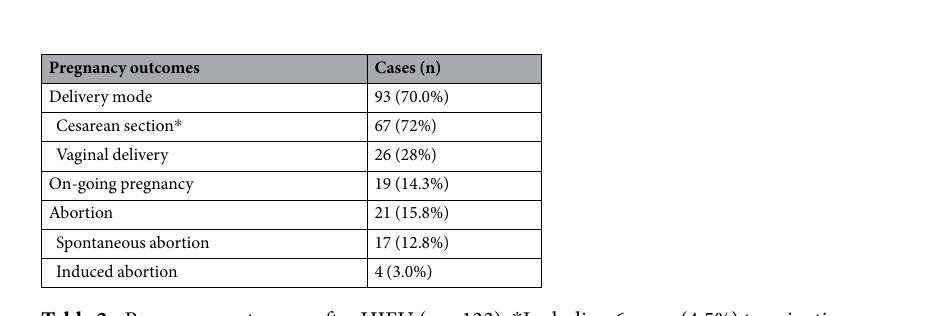
Table 2. Pregnancy outcomes after HIFU (n = 133). * Including 6 cases (4.5%) termination pregnancy in premature for obstetric factors.